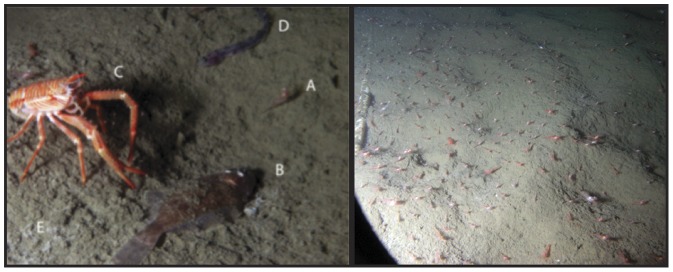
The common species recorded by the camera on VENUS in Saanich Inlet.The right image (Nov. 25, 2009) with Spirontocaris (A), Lyopsetta exilis (B), Munida quadrispina (C), Plectobranchus evides (D) and traces of bacterial mat (E). The left image with numerous Spirontocaris sica was taken on Dec 09, 2009. Images about 20 and 30 cm across.